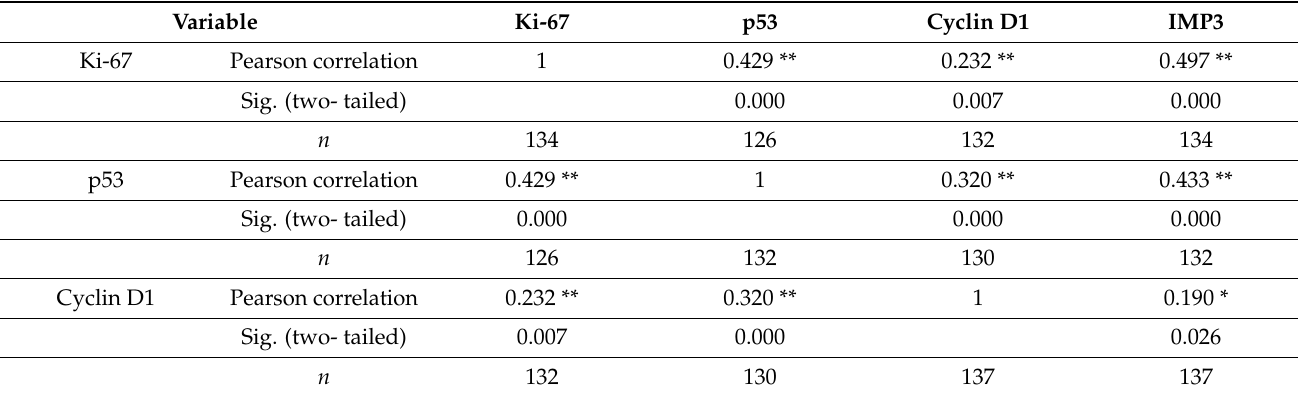
Table 3. Pearson correlations between examined